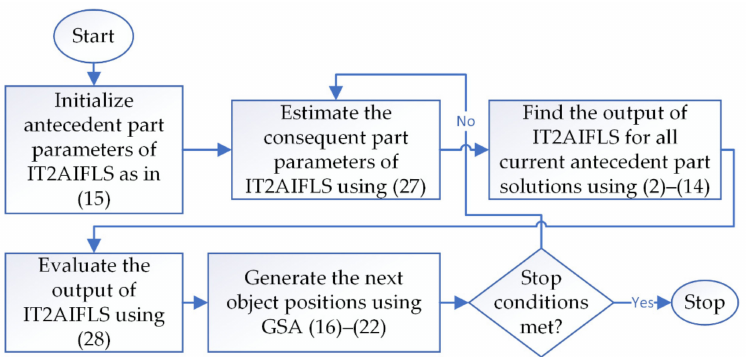
Figure 2. Flow chart of the proposed tuning method for the IT2AIFLS using the GSA for antecedent part parameters and the R-LS algorithm for the consequent part